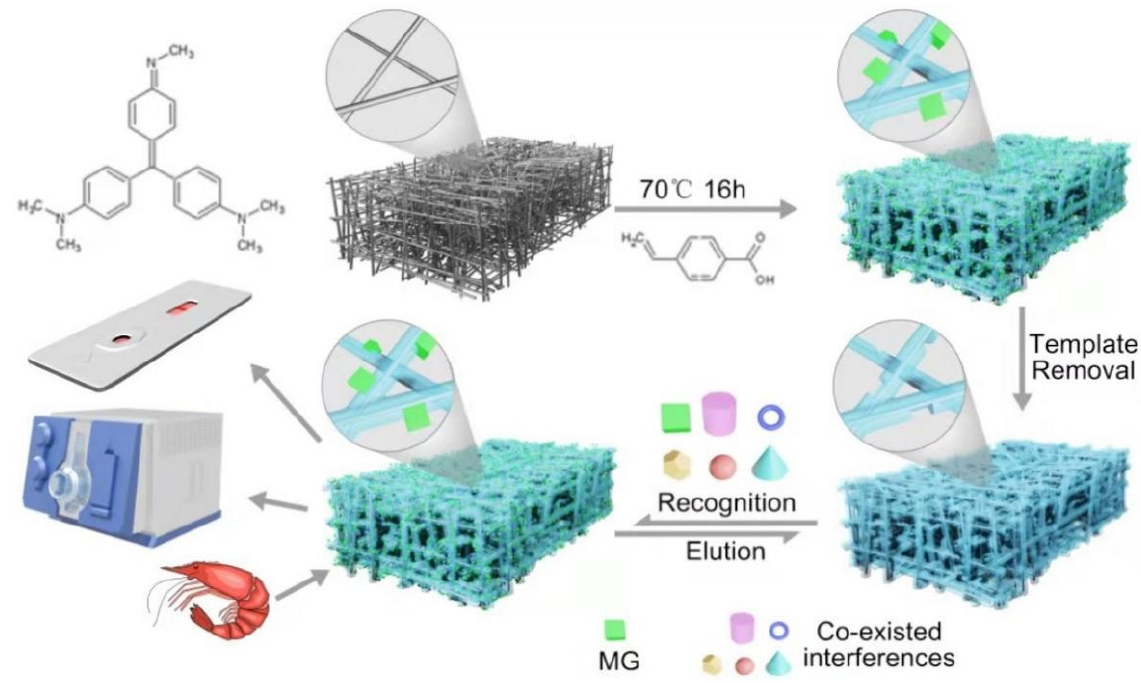
Figure 1. Schematic diagram of surface ‐ coated MIM preparation and analytical procedures.